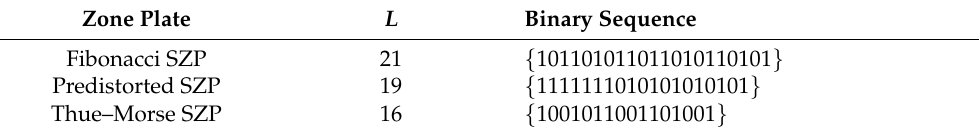
Table 2. Binary sequence examples for different types of